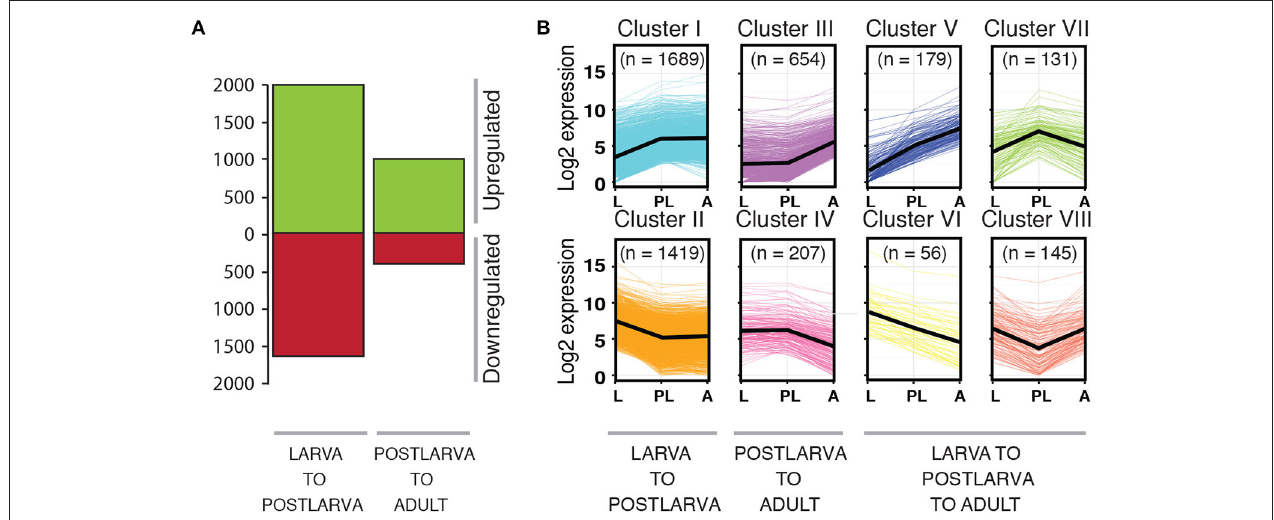
FIGURE 7 | Differential gene expression across the metamorphic transition in Amphimedon queenslandica . (A) Number of genes that are differentially expressed across two major life cycle transitions ( p < 0.05), whether upregulated (green) or downregulated (red). (B) Gene clusters (I–VIII) that share common expression profiles across the life cycle. The black line represents the average trend for each life cycle stage. The number in brackets indicates the number of genes recovered in each gene